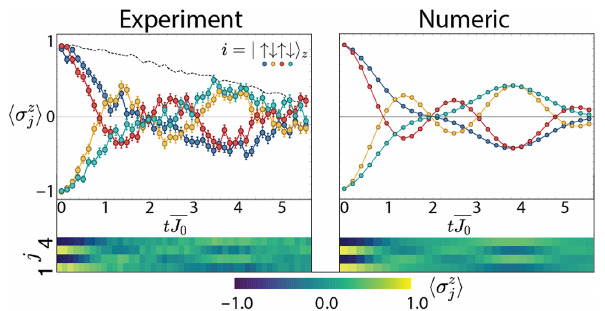
FIG. 7. A comparison of the experimental data with a